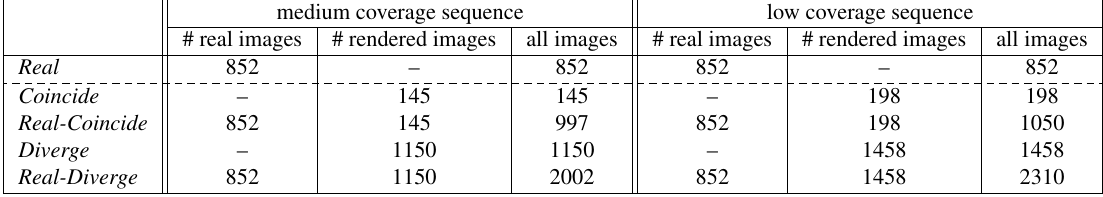
Table 1: Overview of the proposed data sets. The pre-existing Real data set contains 852 images of the Atrium. The Coincide and Diverge data sets are created by rendering images utilizing a 3D model created by Structure-from-Motion (SfM) on the base of the real images from the Real data set. The Real-Coincide and Real-Diverge data sets are joints of the fully synthethic data sets Coincide respectively Diverge and the real training images from the Real data set.